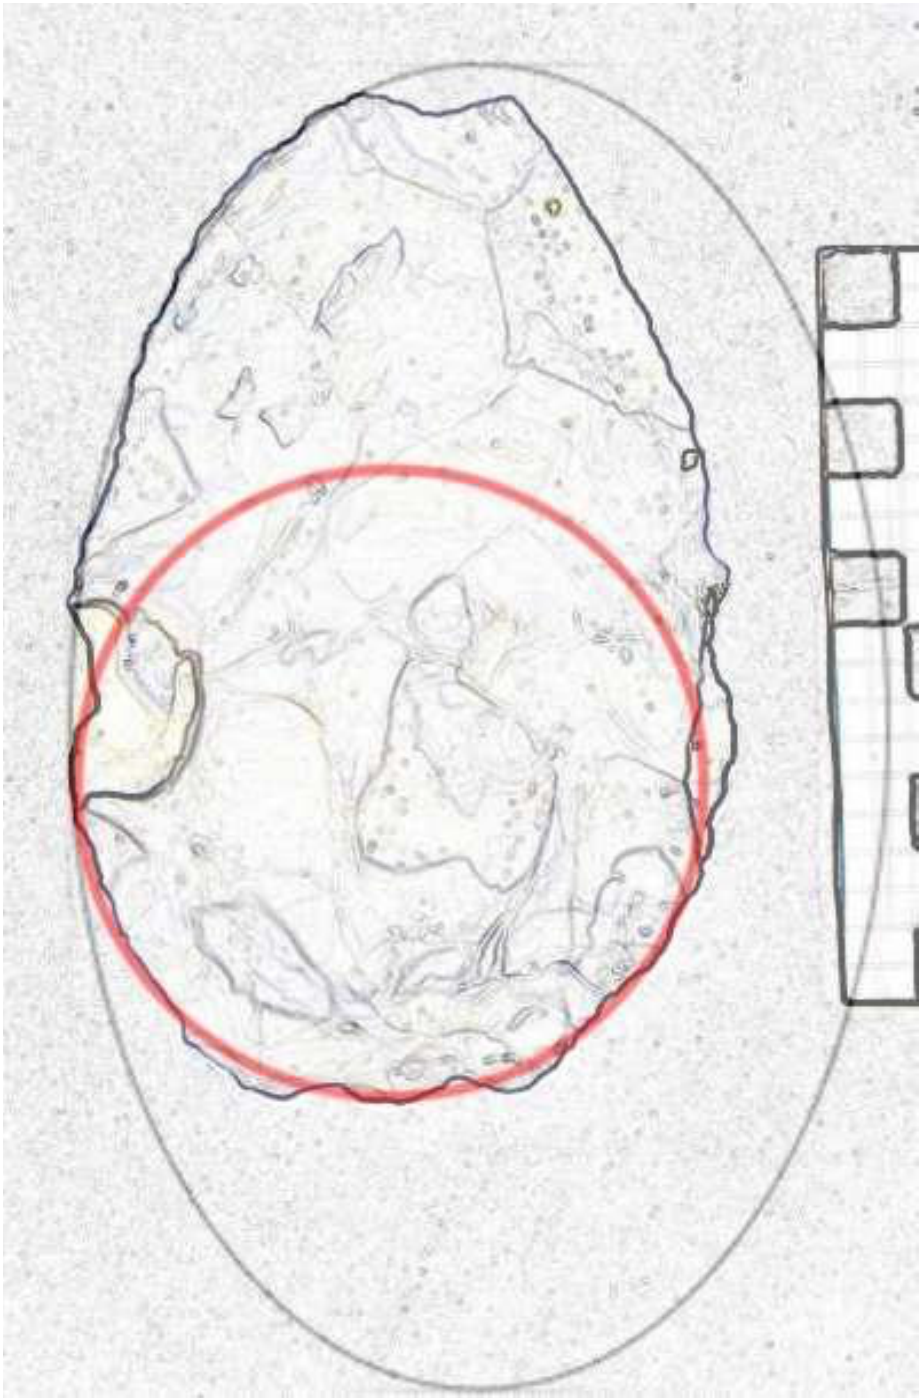
Figure 1. Specimen BD